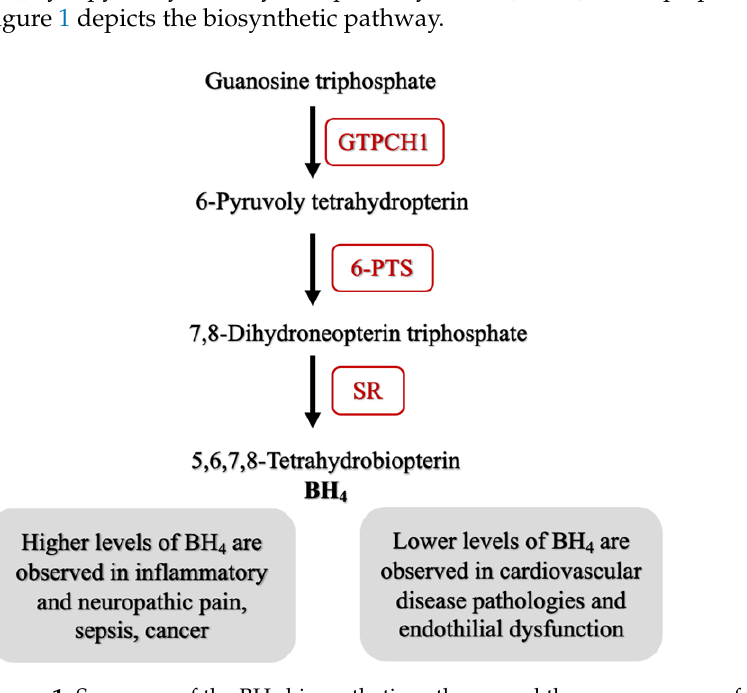
Figure 1. Summary of the BH 4 biosynthetic pathway and the consequences of the altered physiological levels of the cofactor. GTPCH1: GTP cyclohydrolase 1; 6-PTS: 6-pyruvoyl tetrahydrobiopterin synthase; SR: sepiapterin reductase.